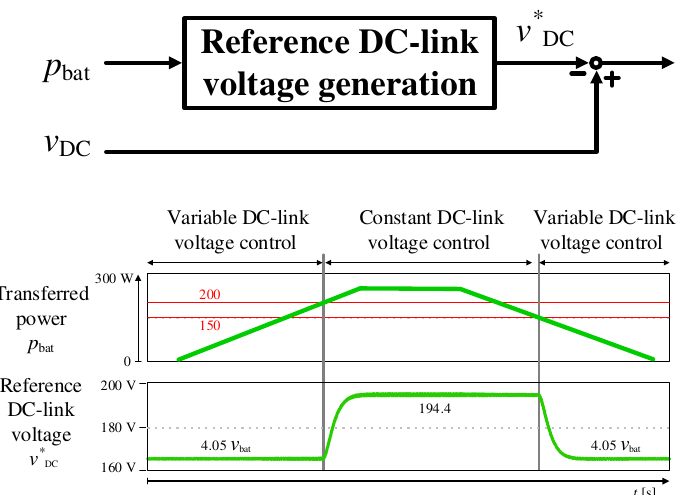
Figure 18. Control block of reference DC-link voltage generation with proposed reference DC-link voltage switchover